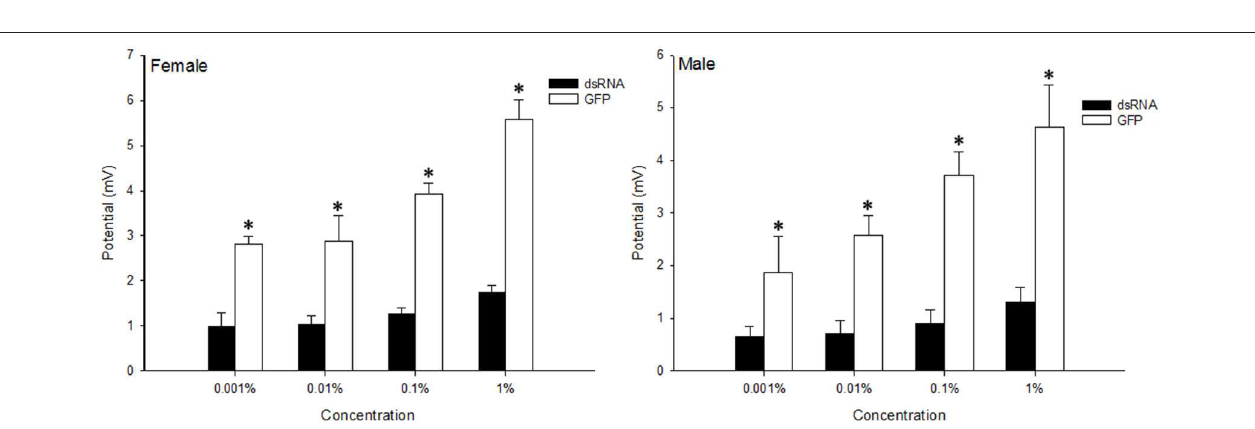
FIGURE 6 | Electroantennographic (EAG) response of B. dorsalis to methyl eugenol attractant following dsRNA injection, compared with that of the insect injected with GFP solution as control. The x-bar represents the concentration of the attractant. Vertical bars indicate the SD of the means ( n = 6), and the asterisks (*) indicate the significant difference at the level of p < 0.05 based on the Student’s t